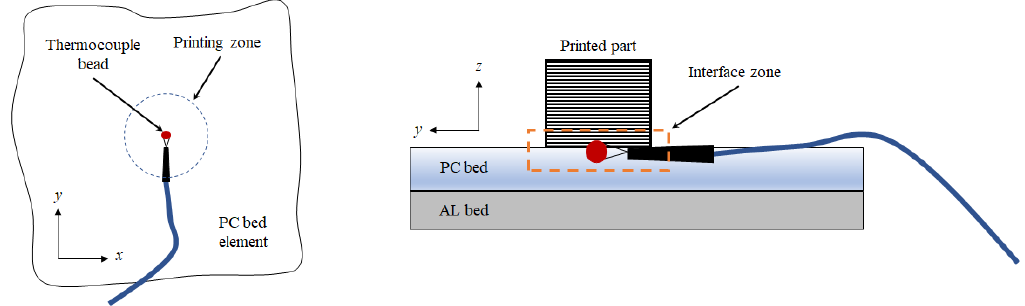
Figure 22. Part interface heating study experiment configuration.